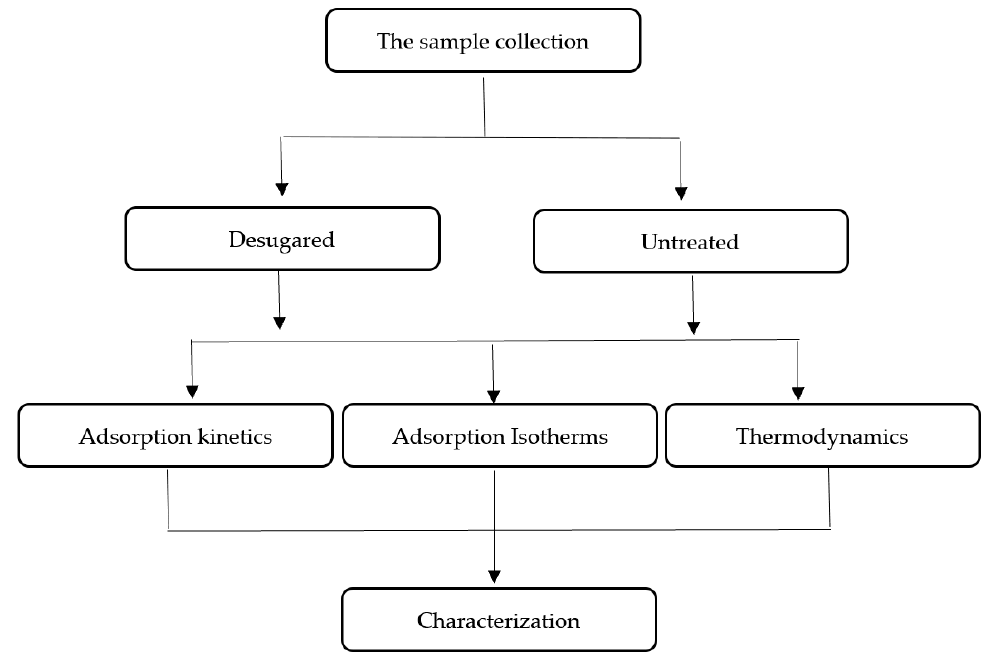
Figure 1. The scheme of the experimental setup.